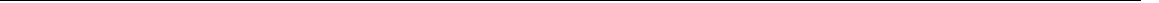
Fig. 1 Increasing the af fi nity of the meditope site. a Surface representation of an IgG with a bound meditope (yellow). Light blue indicates the light chain and white indicates the heavy chain. b Kinetics and thermodynamics of meditope and antibody modi fi cations ( n = 1). Blue points represent data collected at 25 °C. Red points represent data collected at 37 °C (see also Supplementary Table 1). DLE — 5-diphenylalanine long meditope ((Ac)CQFDA (Ph) 2 STRRLRCGGSK) binding to Ile83Glu anti-HER2 memAb; LE — long meditope ((Ac)CQFDLSTRRLRCGGSK) binding to Ile83Glu anti-HER2 memAb; L — long meditope ((Ac)CQFDLSTRRLRCGGSK) binding to anti-HER2 memAb antibody; ori — original meditope (CQFDLSTRRLKC) binding to anti-HER2 memAb. c SPR sensograms of meditope peptide variants binding to immobilized memAb variants at 37 °C ( n = 1). Top, left sensogram — CQFDLSTRRLKC meditope (QFD, original unmodi fi ed meditope) binding to anti-HER2 memAb (original, meditope-enabled anti-HER2 antibody); top, right sensogram — (Ac) CQFDA(Ph) 2 STRRLRCGGSK (5-diphenylalanine long meditope) binding to anti-HER2 memAb; bottom, left sensogram — QFD binding to Ile83Glu anti- HER2 memAb; bottom, right sensogram — 5-diphenylalanine long meditope binding to Ile83Glu anti-HER2 memAb. Residues highlighted in green correspond to modi fi cations in the meditope (position 5, top panel) or Fab (position 83 LC, left